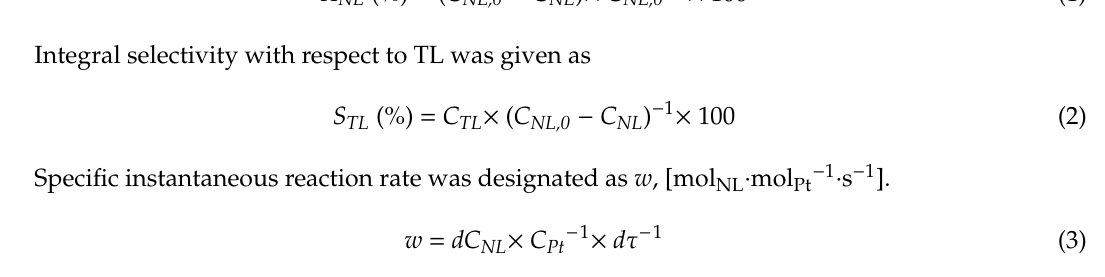
Figure S1: Deconvolution of Pt 4f for Pt-HAP: initial ( a ) and reduced for 3 h ( b